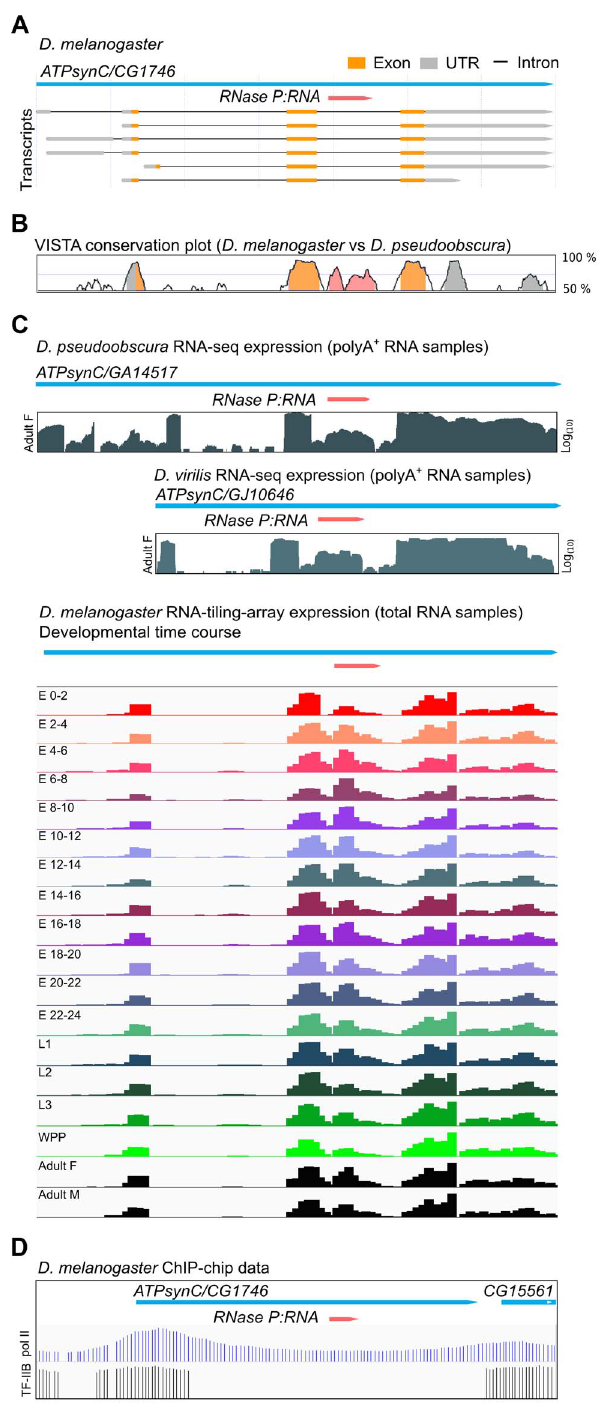
Fig. 1. DrosophilaRPR is embedded in an intron and ubiqui- tously expressed. A. The RPR gene (pink) in D. melanogaster is present in the last intron of ATPsynC / CG1746 . B. This arrangement is conserved in D. pseudoobscura (and other members of the genus ). The exons of ATPsynC (orange peaks) are highly conserved between these species, as is the region within the intron that contains RPR (pink). The preceding intron is not conserved. Untranslated regions of ATPsynC are shown in grey. Peaks showing 75% or greater conservation are colored. C. Analysis of polyA-selected RNA [52] from D. pseudoobscura and D. virilis, and of total RNA from different developmental stages of D. melanogaster show that the region corresponding to RPR is